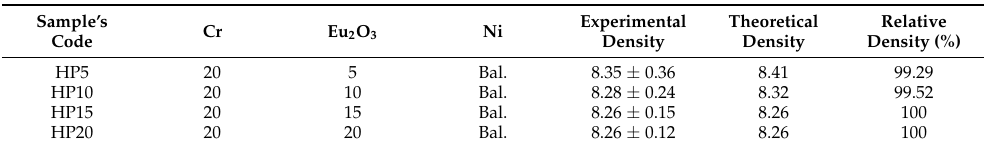
Table 1. The composition (wt.%), experimental density, theoretical density, and relative density of